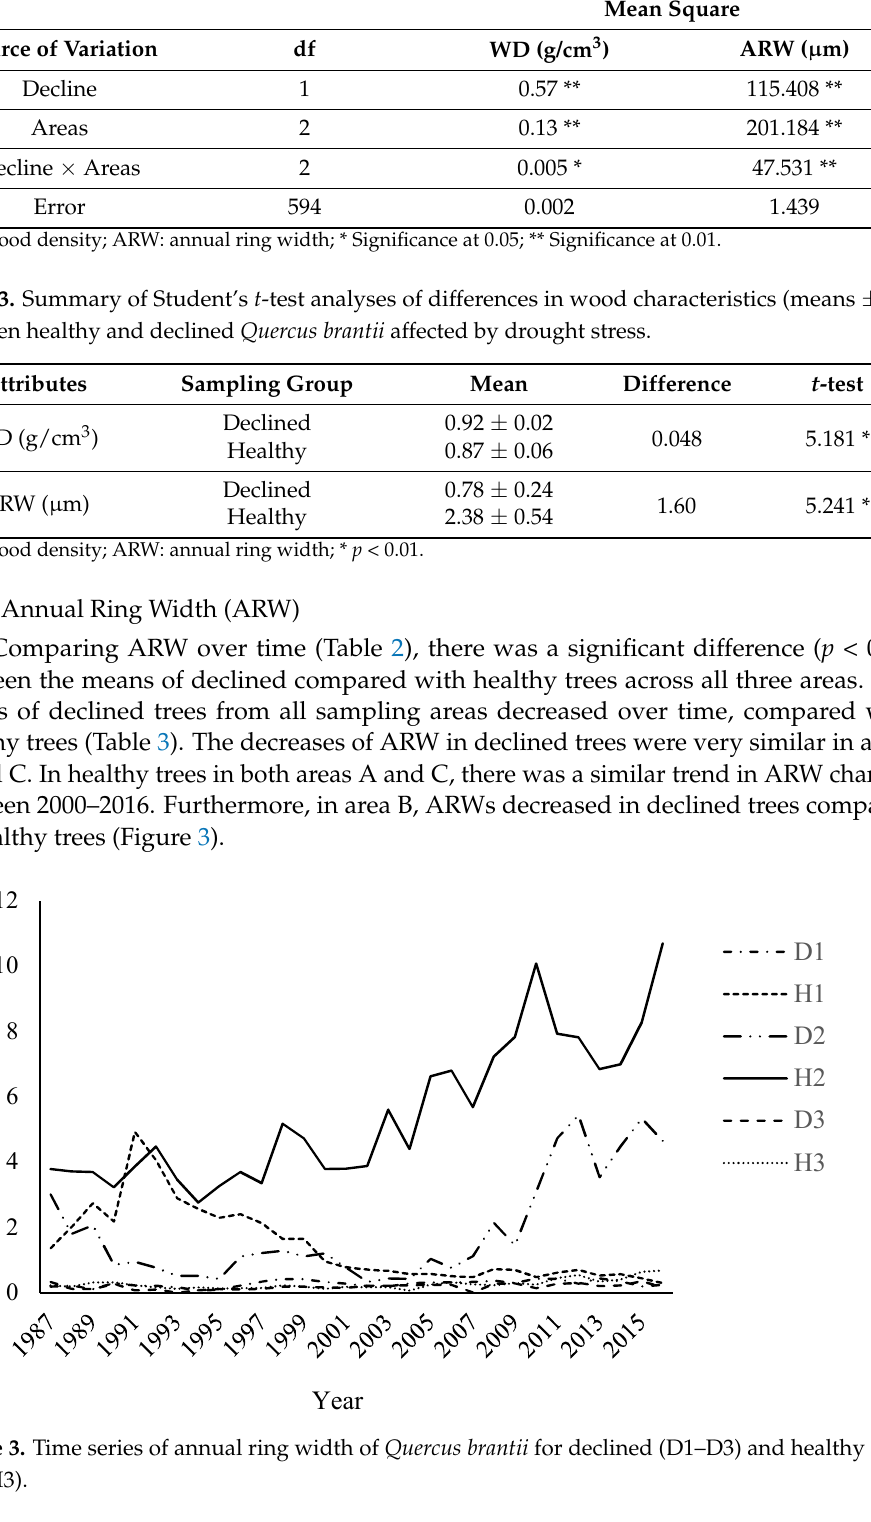
Table 2. One-way ANOVA summarizing the significance of wood-anatomical variables (WD: wood density; ARW: annual ring width) between healthy and declined Quercus brantii trees affected by drought stress in three oak forest areas in Iran.